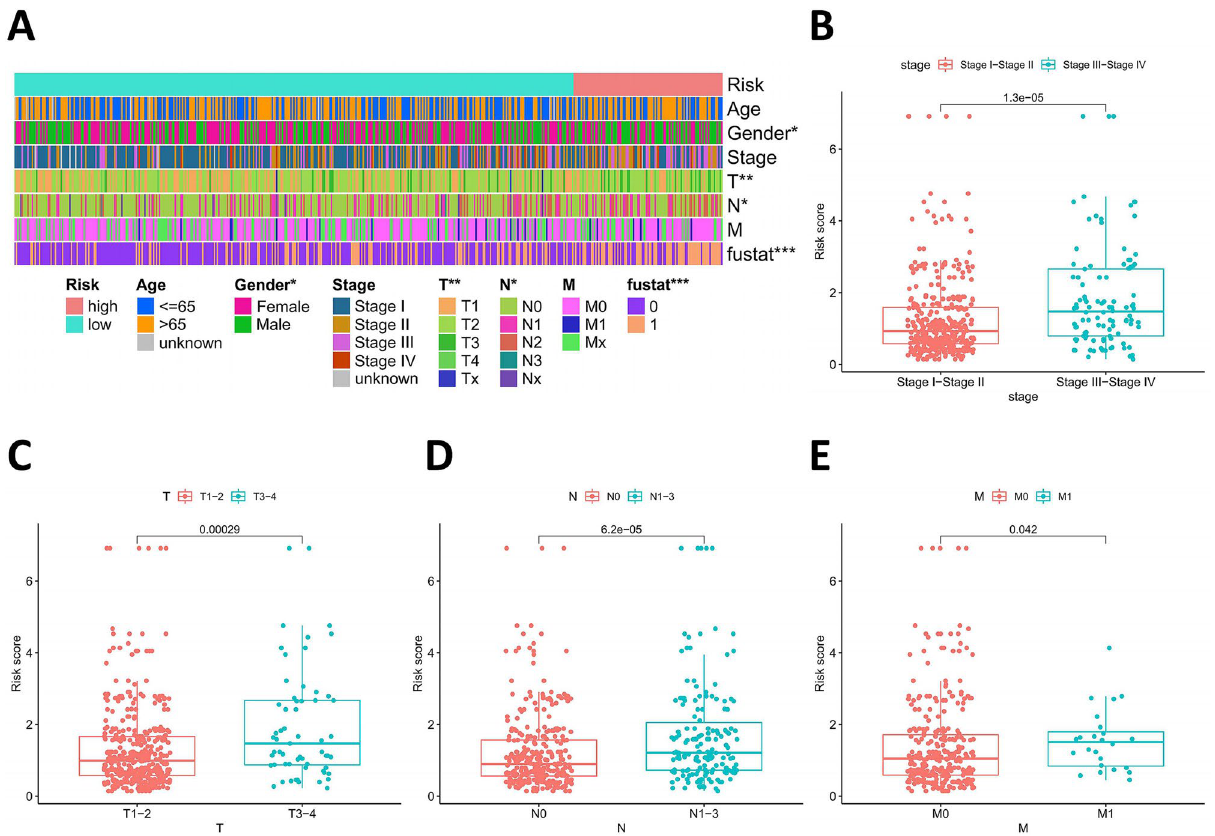
Figure 3. The clinical correlation between risk model and clinicopathological characteristics of LUAD patients. ( A ) The chi-square test showed that gender (P < 0.05), T stage (P < 0.01), N stage (P < 0.05), and survival status (P < 0.001) were significantly related to the risk model. ( B-E ) The Wilcoxon rank-sum test showed that the risk scores of LUAD patients were significantly related to clinical stage ( B ), status of primary tumor ( C ), status of lymph node metastasis ( D ), and status of distant metastasis ( E ). LUAD, lung